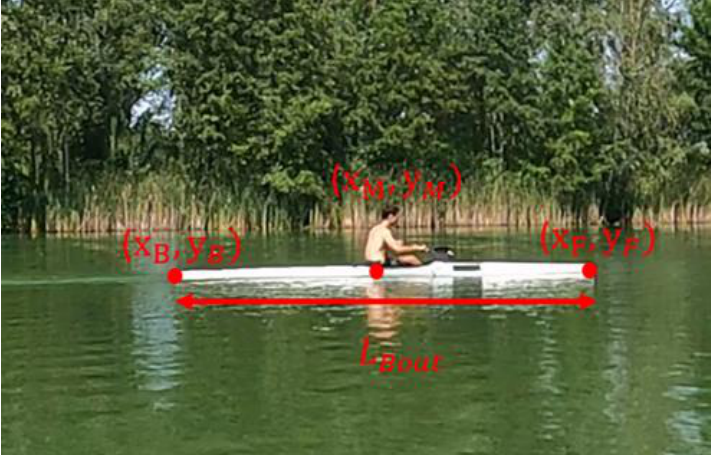
Figure 4. Description of the notation used to compute the velocity of the boat. The coordinates ( x , y ) are in pixels whereas L boat is in